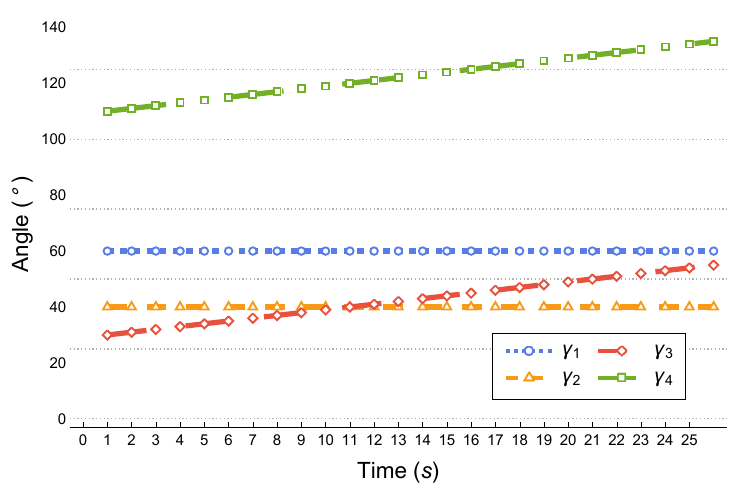
Figure 14. Inverse kinematics angles γ 1 , γ 2 , γ 3 , γ 4 . Figure 14 obtains the numerical values of the four angles of the inverse kinematics.